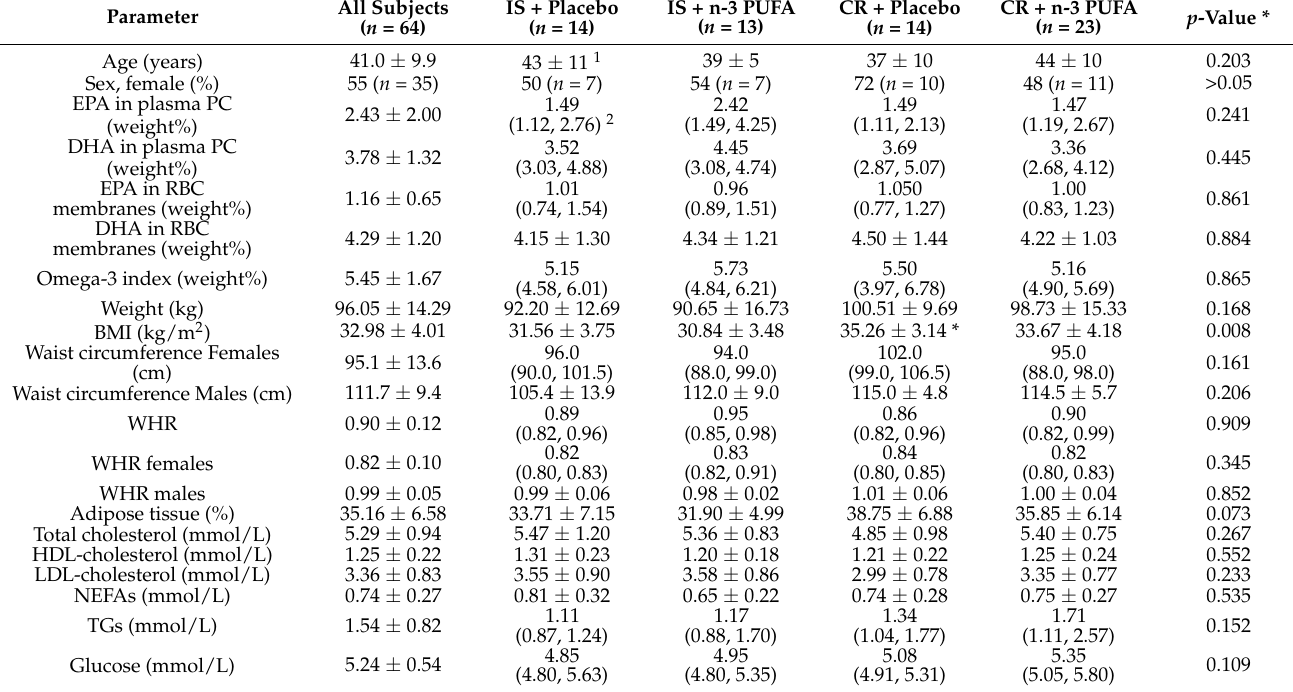
Table 1. Baseline characteristics of the subjects participating in the